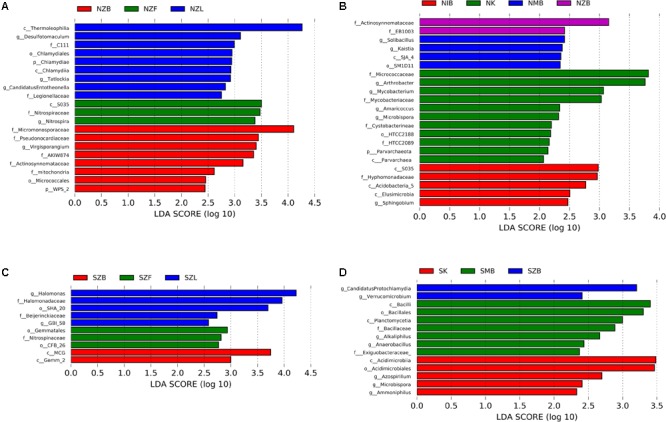
LEfSe analysis with LDA values higher than two among methods with different physical lysis steps in the normal soil (A), the saline soil (C) and among different methods with the same bead beating step in the normal soil (B), the saline soil (D). The labels (p, c, o, f, g) before each taxon represented phylum, class, order, family, and genus, respectively.